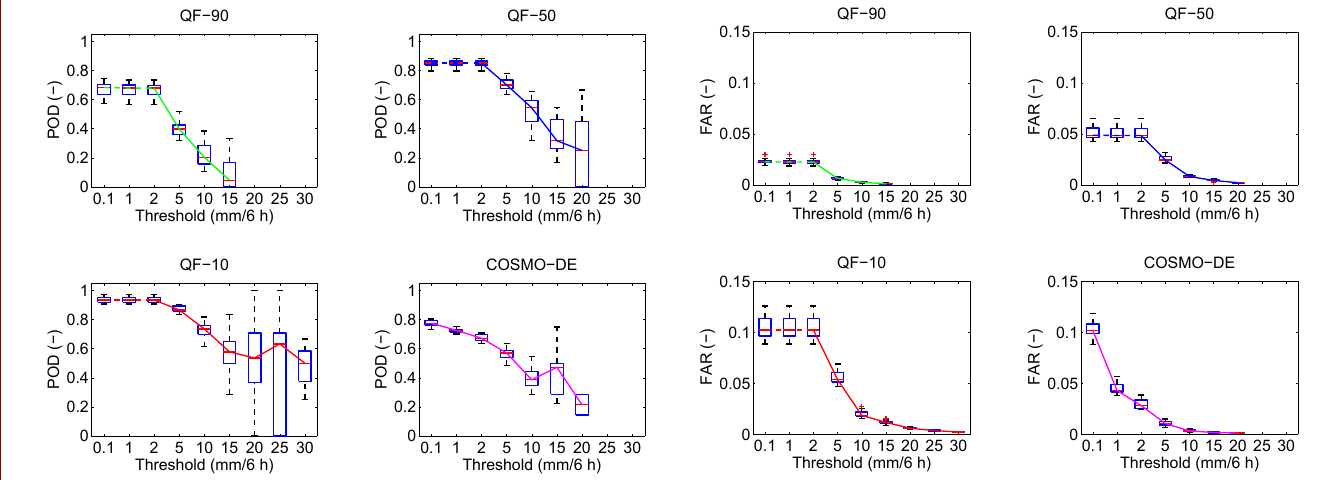
Figure 4. Probability Of Detection (POD) according to thresholds of areal precipitation sums ranging from 0.1 to 30mm/6h for the Quantile Forecast and COSMO-DE from April 2011 to June 2014. The box plots indicate the spread of POD over the 16 forecast areas.